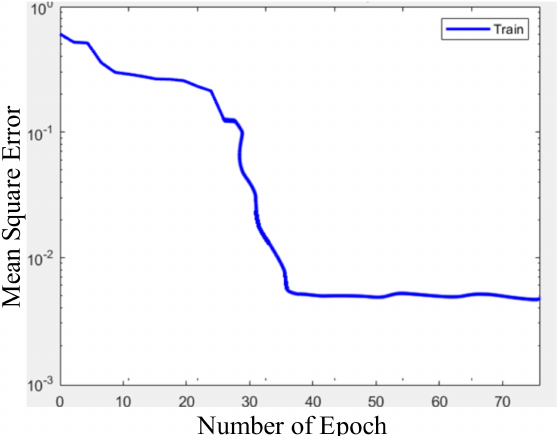
Figure 10. Performance graph of the flow regime classifier network.